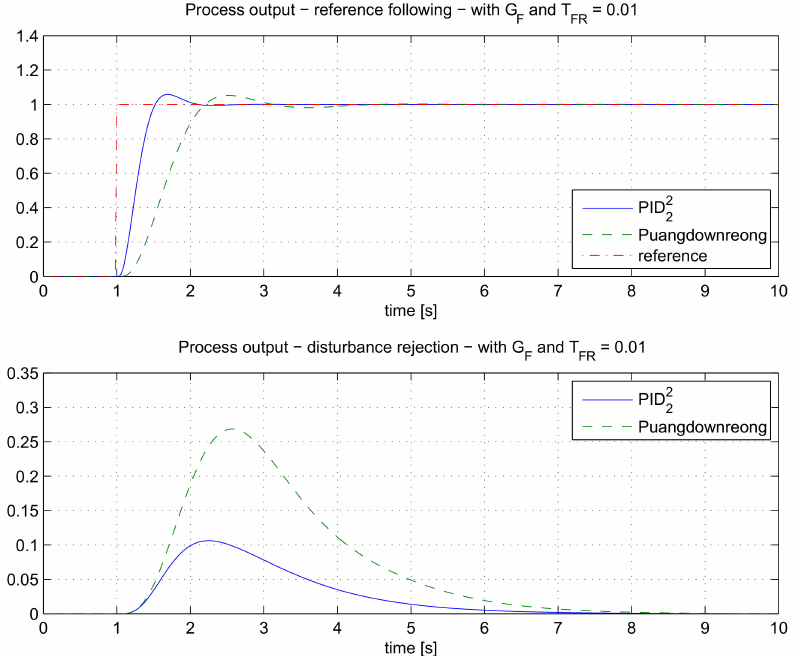
Figure 15. The comparison of the closed-loop responses for the process G P 6 (s) when using PID 2 the Puangdownreong controller.